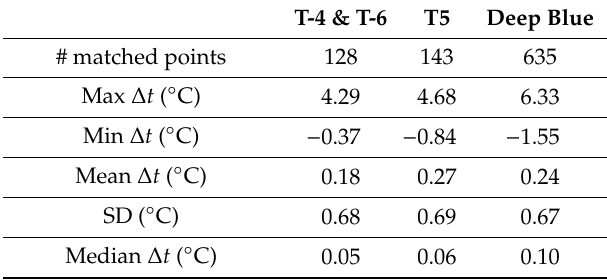
Table 6. ∆ t ( XBT-Argo) for each XBT type involved. Depth: 0–100 m ( ± 1